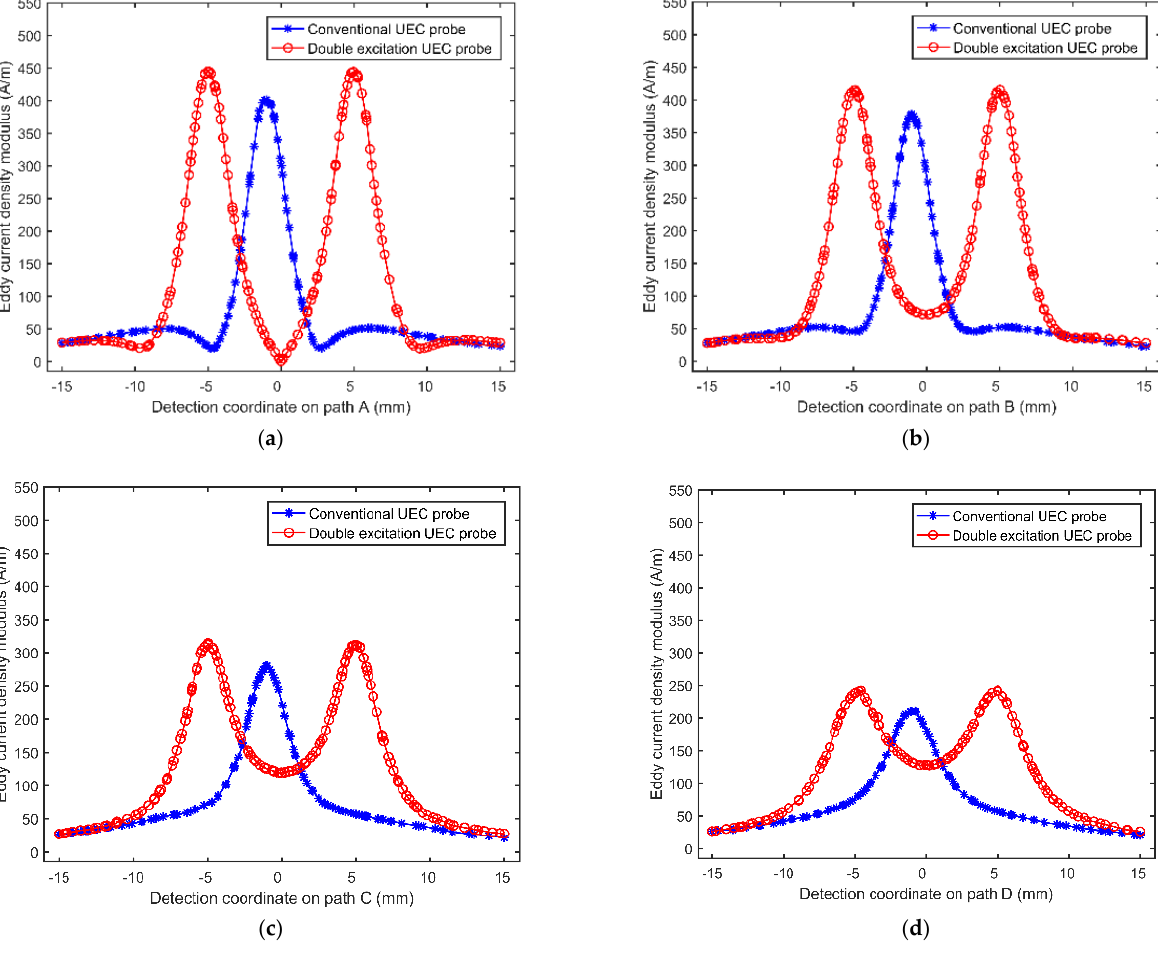
Figure 5. The relationship of the eddy current intensity modulus depending on the detection coordinate: ( a ) line A; ( b ) line B; ( c ) line C; ( d ) line D.